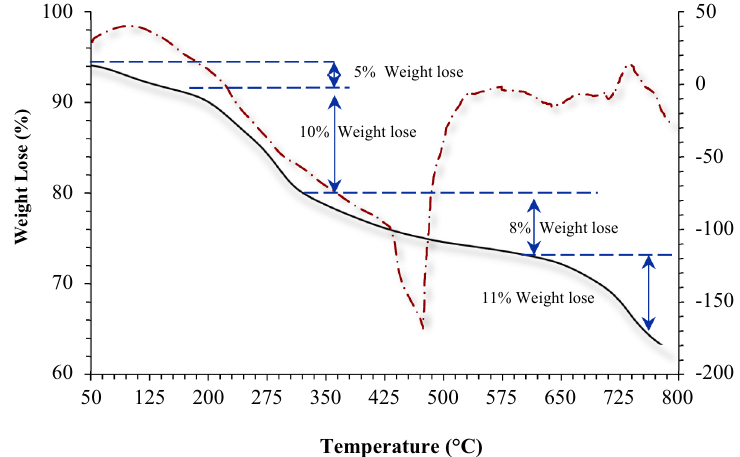
Figure 4. The TGA curve of the Fe 3 O 4 @Pectin@(CH 2 ) 3 -Acetamide-Cu(II).